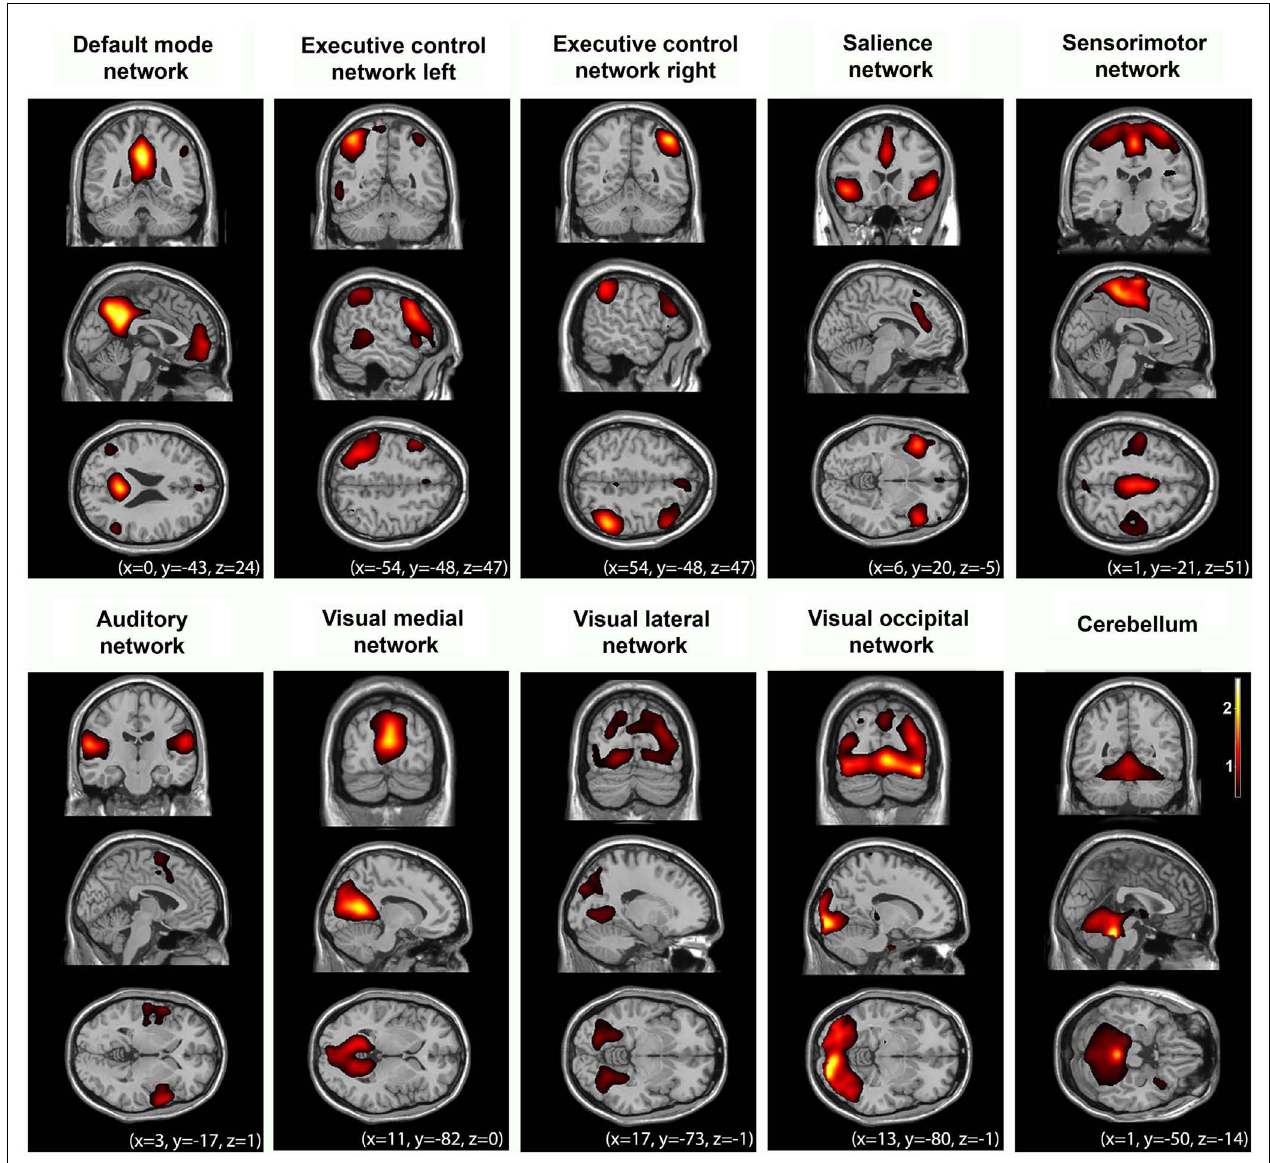
sensorimotor, and sensory (auditory, visual) function. For illustrative purposes, group-level spatial maps ( z values) are rendered on a structuralT1 magnetic resonance template and x , y , and z values indicate the Montreal Neurological Institute coordinates of the represented